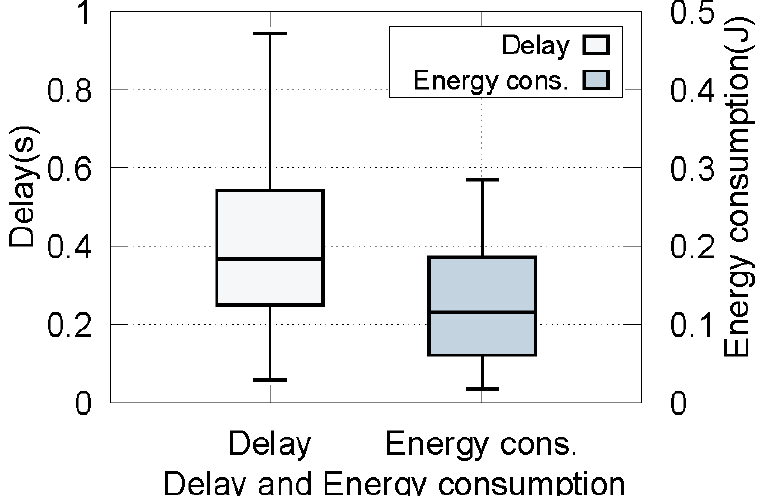
Figure 10. Delay and energy consumption of all